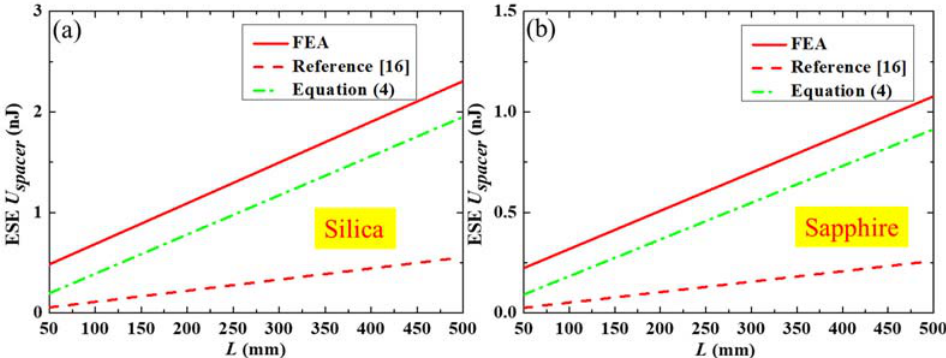
Figure 5. ESE as a function of the length L of the spacer made of low ‐ temperature materials. The solid red line presents the simulation results. The red dashed line denotes the analysis estimates based on Equation (2) in ref. [16]. The green dash–dot line denotes the analysis estimates based on Equation (4). ( a ) All ‐ silica USC. ( b ) All ‐ sapphire USC.